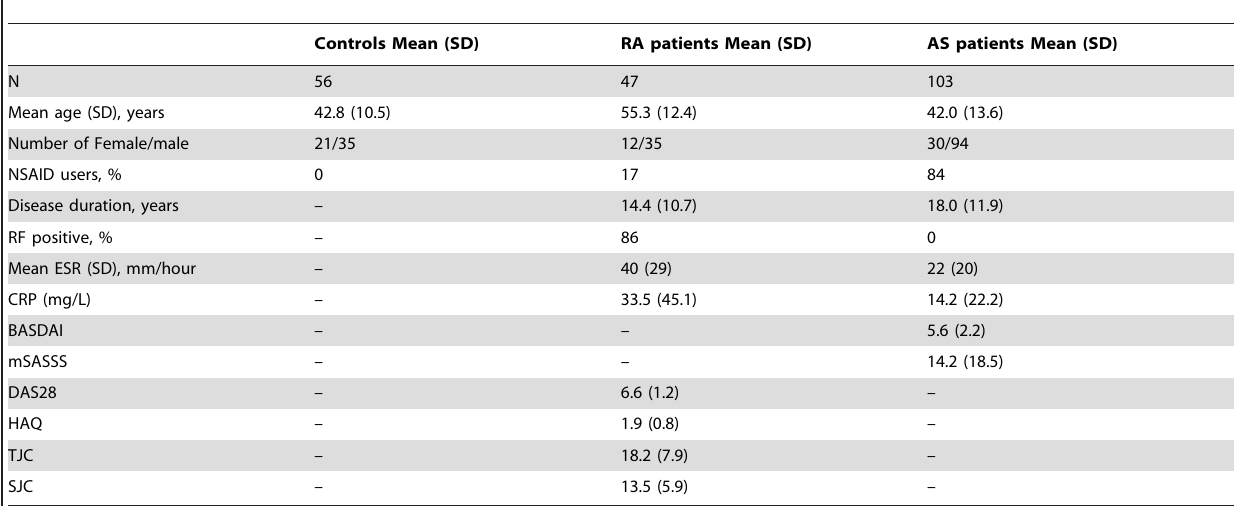
Table 1. Baseline demographics and clinical assessment scores for the healthy controls, RA and AS patients.